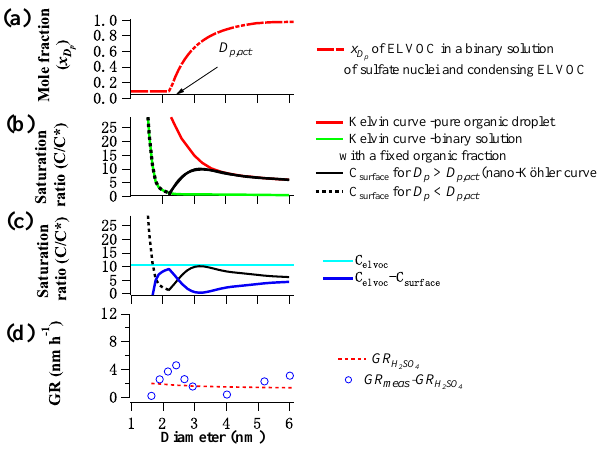
Figure 8. (a) Mole fraction of organics ( x D ) in a binary solution p of sulfate nuclei and activating organics (ELVOC) in a new par- ticle. Nuclei activation diameter D p , act is the size where ELVOC begins to dilute the nuclei. (b) Kelvin equilibrium curves over a pure organic droplet (red line) and a binary solution with a fixed organic fraction (green line), nano-Köhler curve for D p > D p , act (black solid line) and surface concentration C surface for D p < D p , act (black dashed line). (c) Gas phase concentration of the organic vapor ( C elvoc , cyan line), surface concentration C ∞ (black line), and C elvoc − C surface (blue line). (d) Growth rate GR H due 2 SO 4 to H 2 SO 4 (Mikkonen proxy) and growth rate due to organic vapor GR elvoc , meas , calculated as GR meas − GR H 2 SO 4